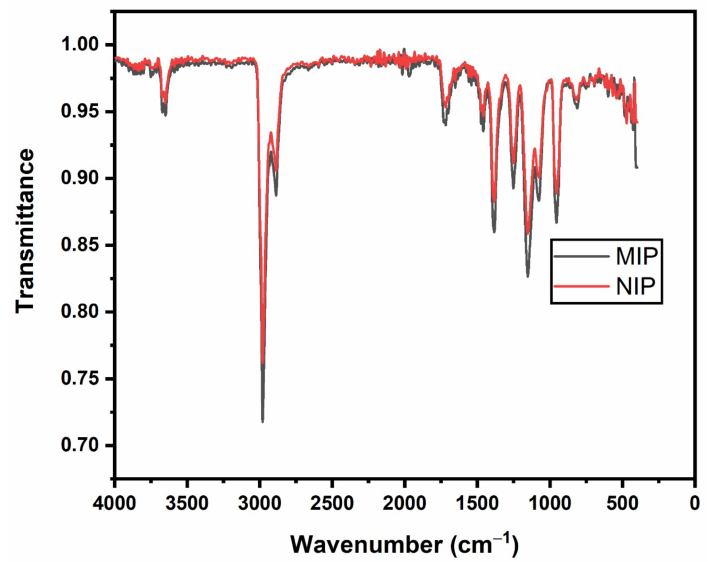
Figure 1. Fourier transform infrared spectra (FTIR) for the molecularly imprinted polymer (MIP) and nonimprinted polymer